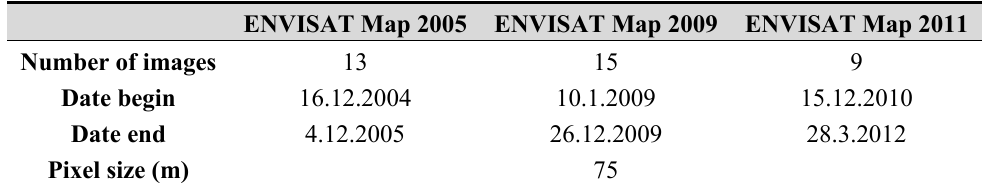
Table 4. Summary of the land-use maps derived from ENVISAT ASAR images.